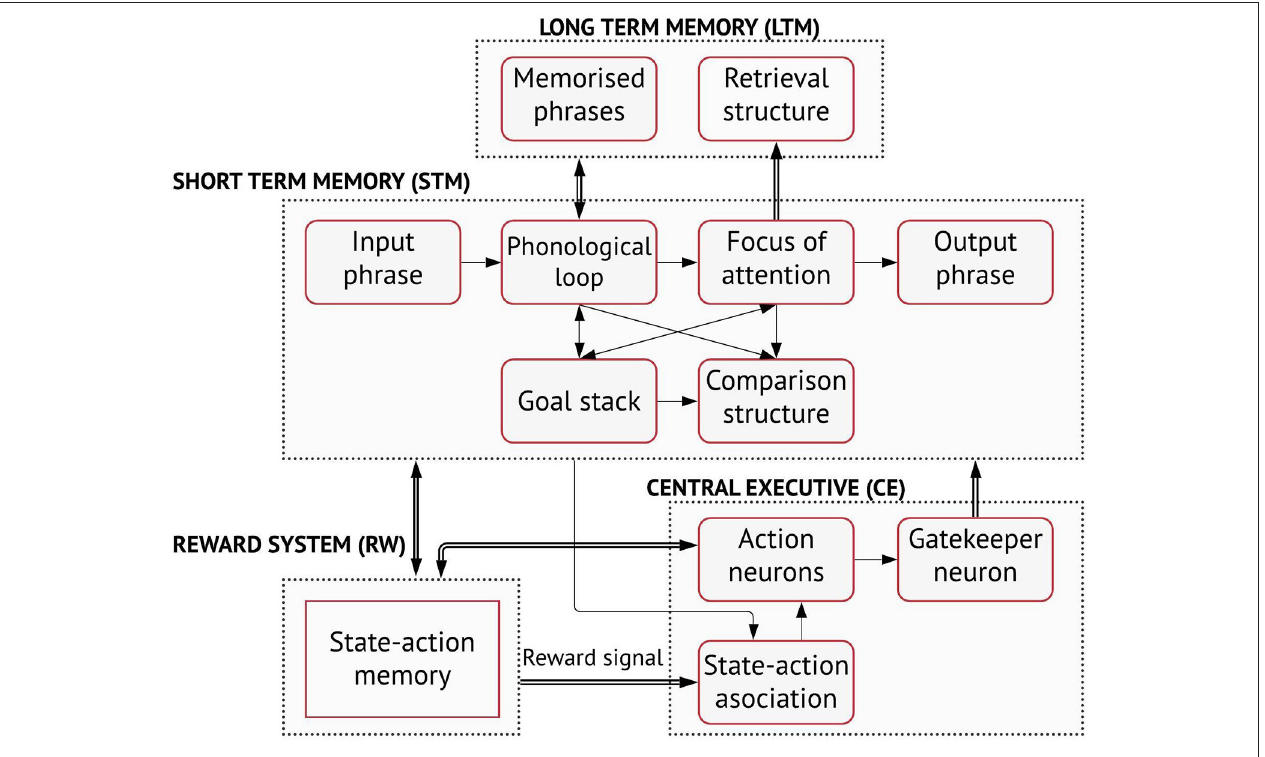
FIGURE 1 | The cognitive architecture (courtesy of Golosio et al.,